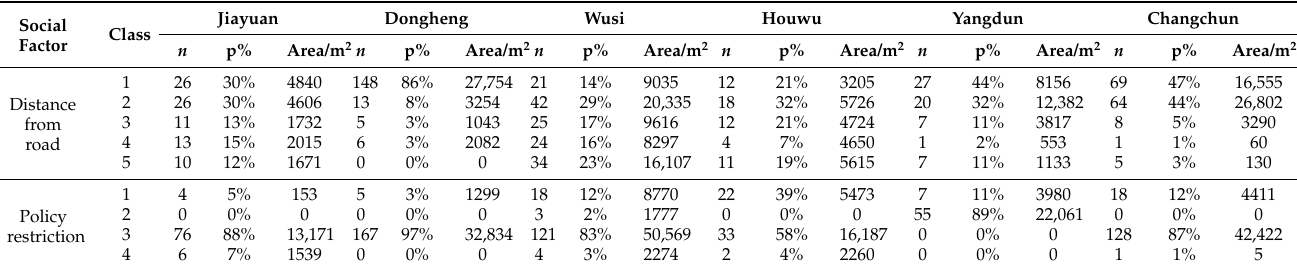
Table 7. Distribution of homesteads by social factor